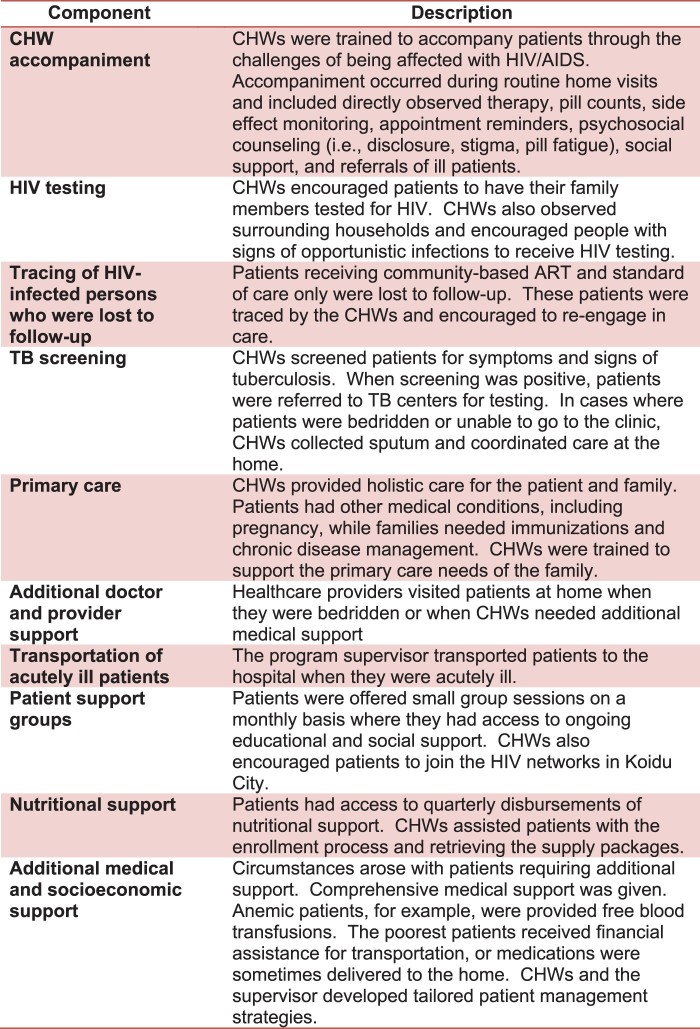
Components of the community-based ART programme and their descriptions.